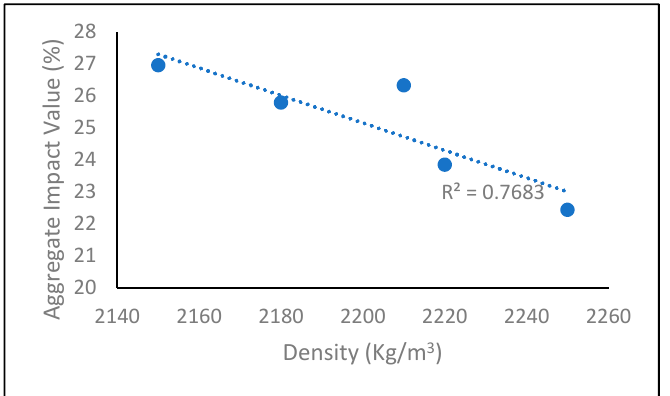
Figure 5. Correlation between AIV and the density of the fly ash geopolymer aggregate.